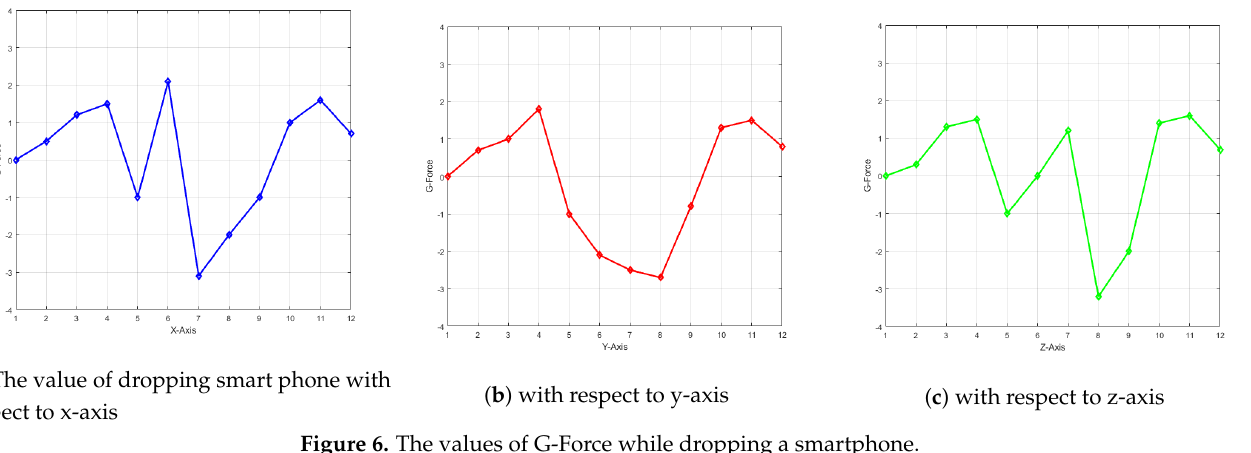
Figure 6. The values of G-Force while dropping a